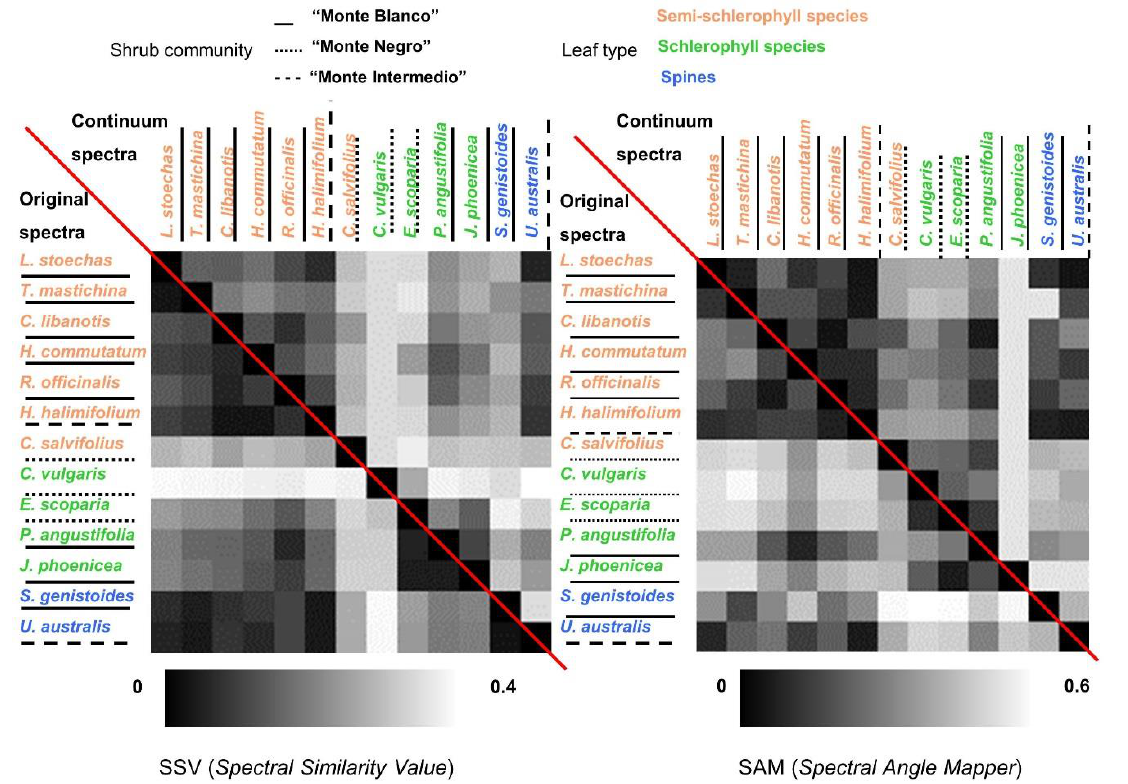
Figure 6. Matrix of spectral similarity indexes in grayscale, where black indicates total similarity and white the highest dissimilarity for the dominant and the less abundant shrub species in Doñana National Park. Foliage type is also shown by coloring the species name. Species names are also underlined according to the shrubland community they belong